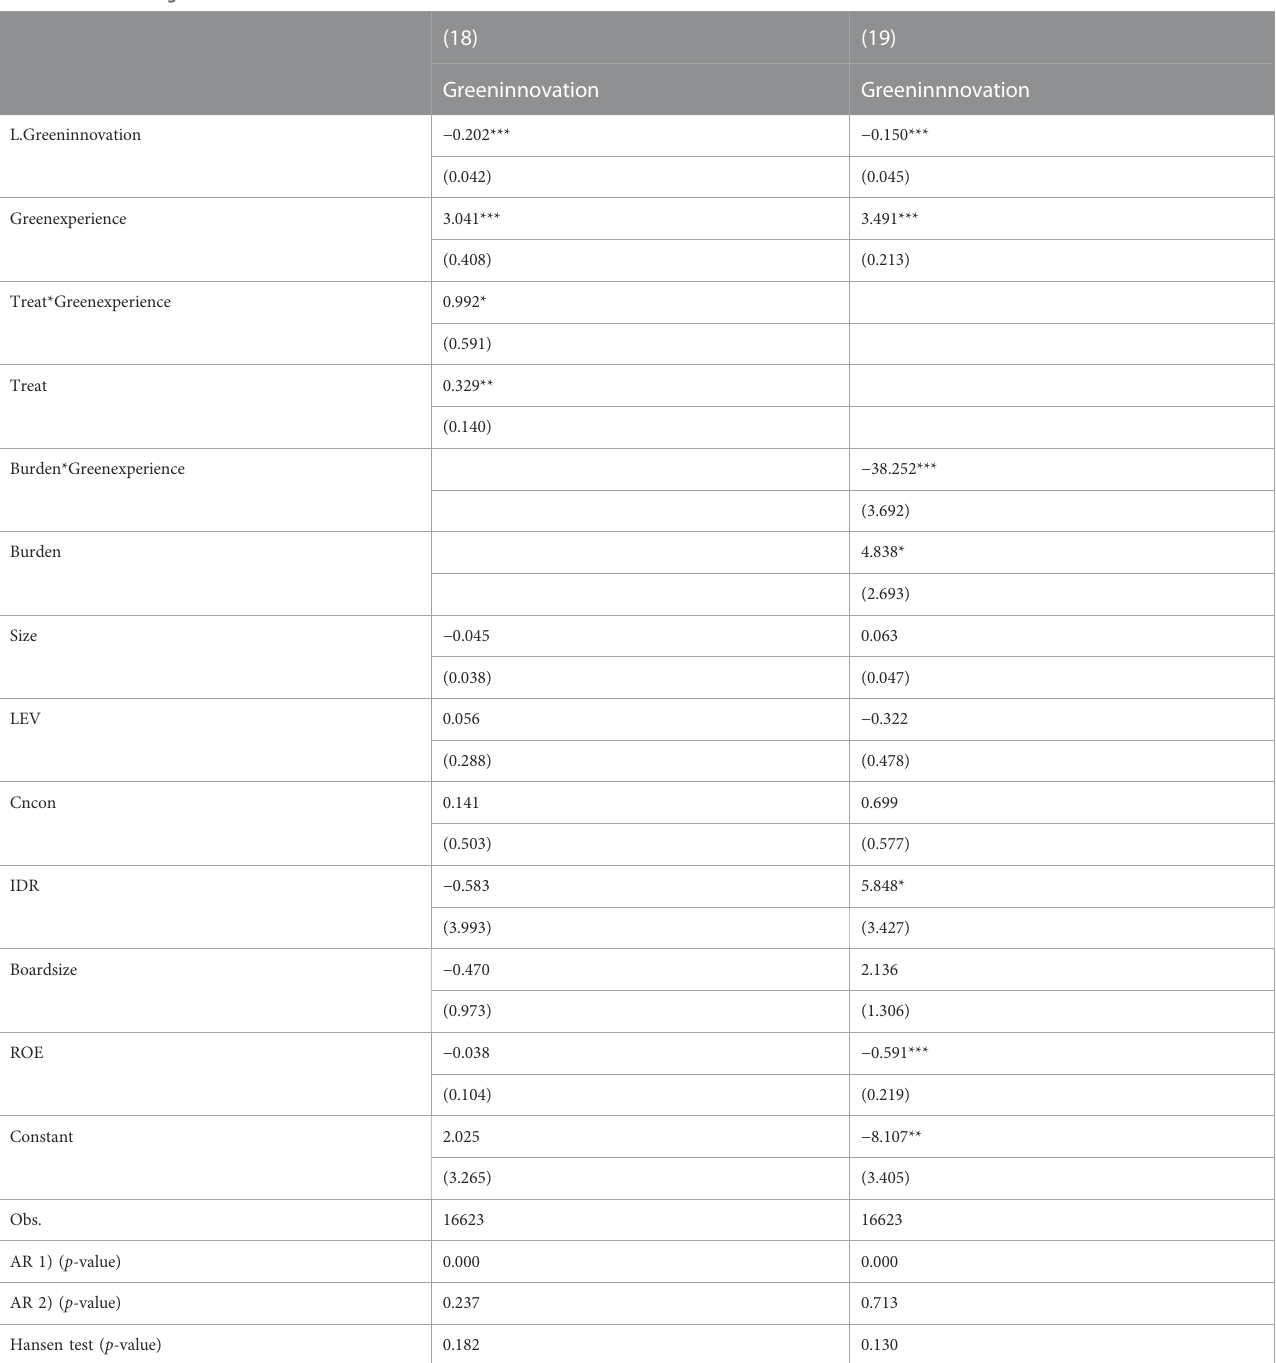
TABLE 9 SYS-GMM regression